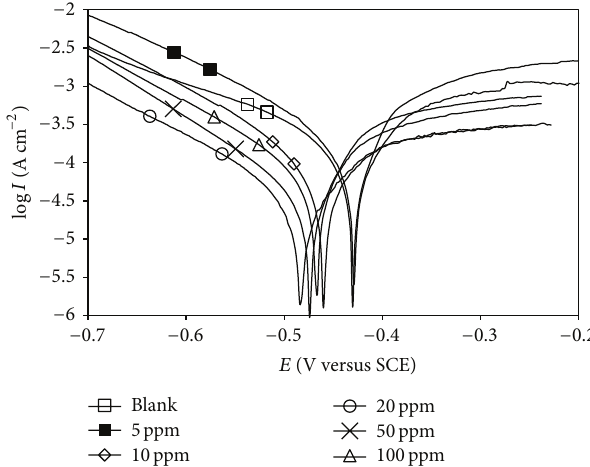
Figure 3: Polarization plots for composite coatings obtained from plating bath containing different concentration of nano-Al 2 O 3 particles.